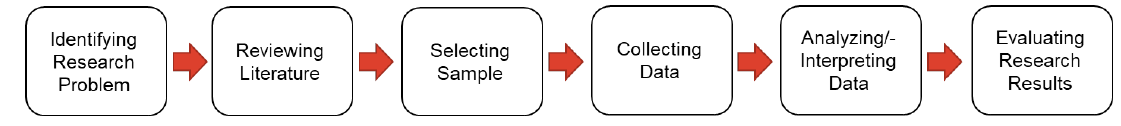
Figure 7. Stages of the research approach adopted.